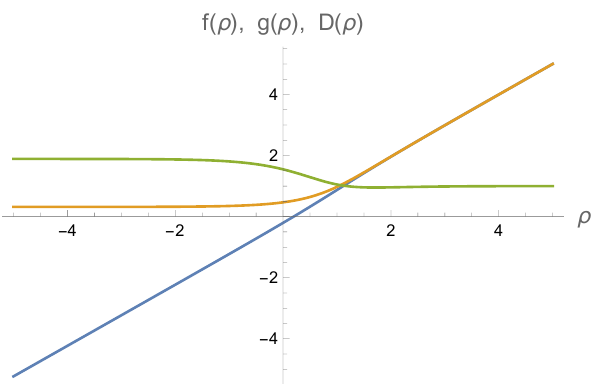
Figure 6. Flow solution for a T 2 compactification, with f , g and D in blue, orange, and green, re-